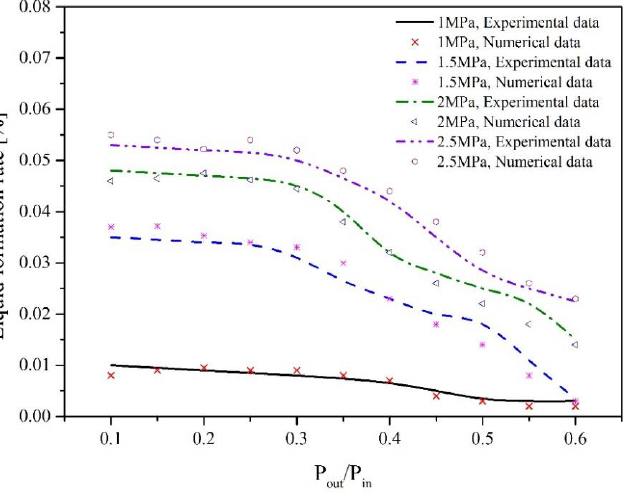
Figure 7. Variation in the liquid formation rate with the change in inlet pressure and back pressure.